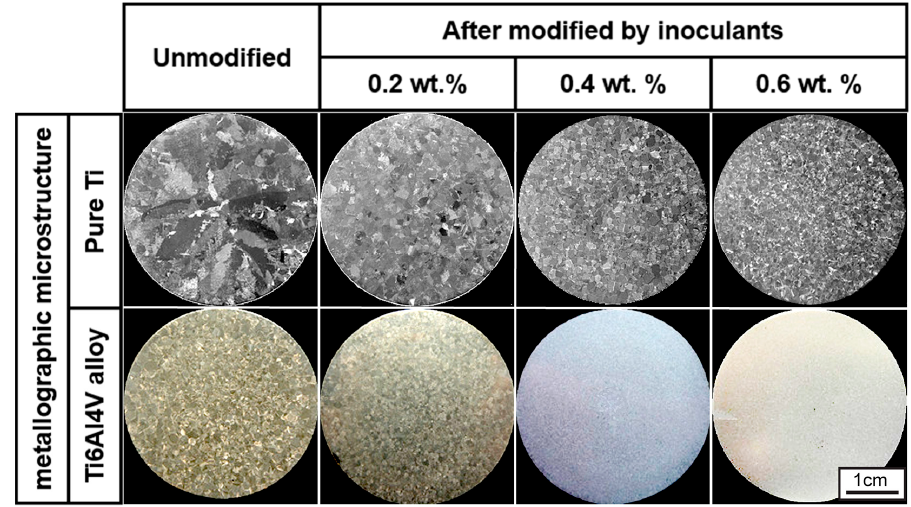
Figure 5. The metallographic microstructure of pure Ti and Ti6Al4V alloys unmodified and modified by in situ Ti 5 Si 3 /Ti composite ribbon inoculants with different weight percentages.